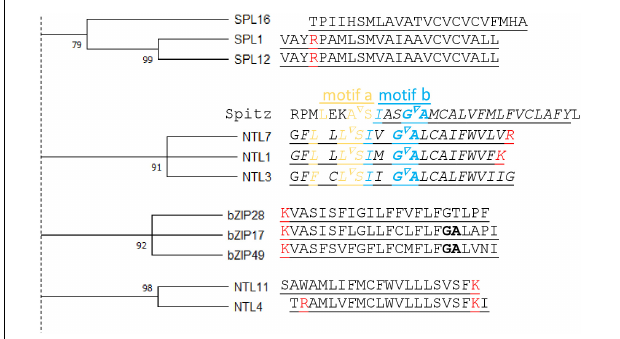
FIGURE 3 | Transmembrane domain similarities of atMB-TFs. Left, A bootstrap (1,000 replicates) consensus tree was constructed from all atMB-TF transmembrane domains (TMDs) (Tamura et al., 2021) (for the complete tree, see Supplementary Figure 1 ). Here, only clusters with bootstrap values higher than 70 are displayed. Right, Alignment of the TMD amino acid sequences with positive amino acids (lysine and arginine, red) and helix-breaking residues (bold) indicated. For NTL7, the alignment is presented with the Drosophila melanogaster Rhomboid-1 recognition (motifs a and b) and cleavage (inverted triangle) sites from the Spitz substrate TMD